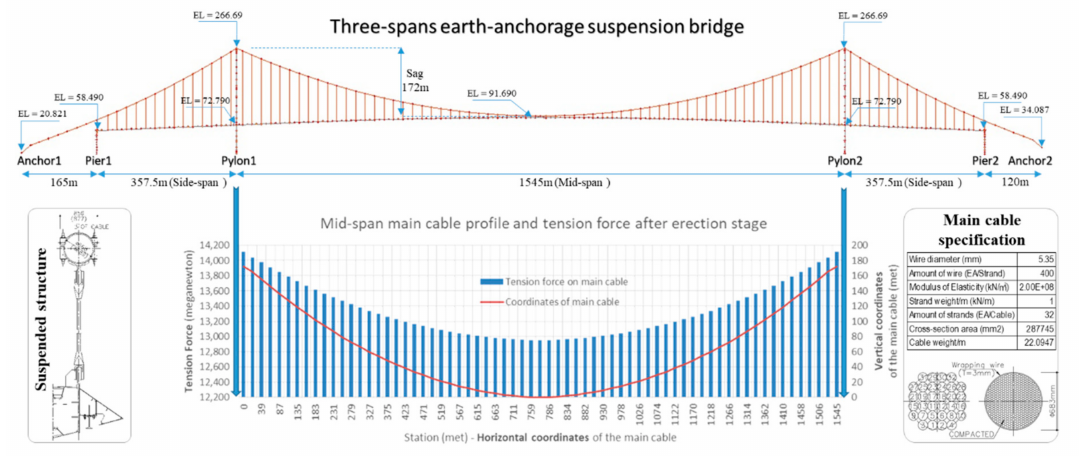
Figure 13. Necessary coordinates and initial cable force of the main cable determined using RM Bridge